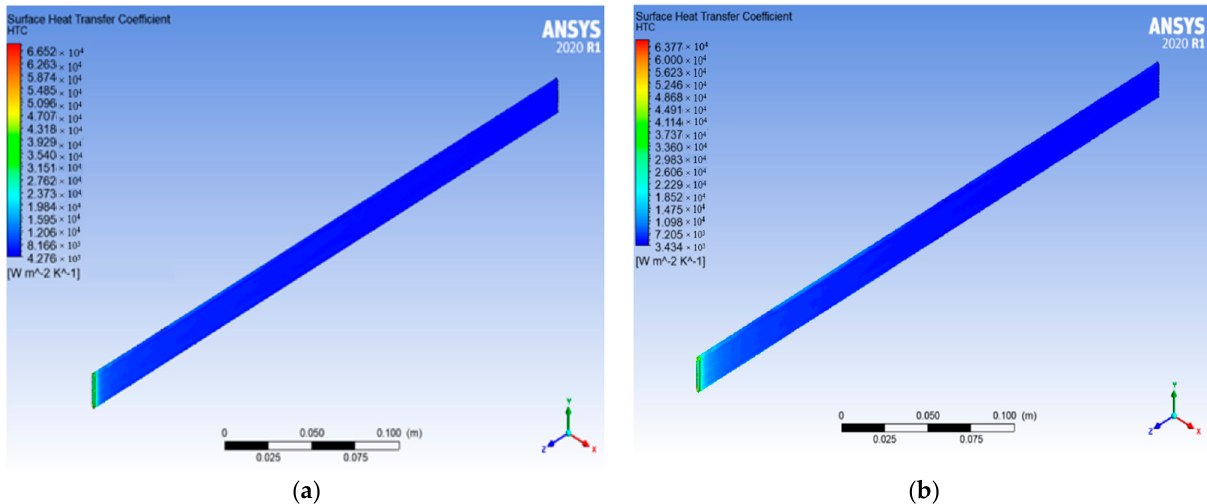
Figure 21. The pipe simulation at actual size: ( a ) G + CNC (0.2%); ( b ) G + CNC (0.01%). According to the simulation images above, the actual radiator tube size achieves 6860.17 W/m 2 K for GNP/CNC (0.2%) and 5780.07 W/m 2 K for GNP/CNC (0.01%). The tube